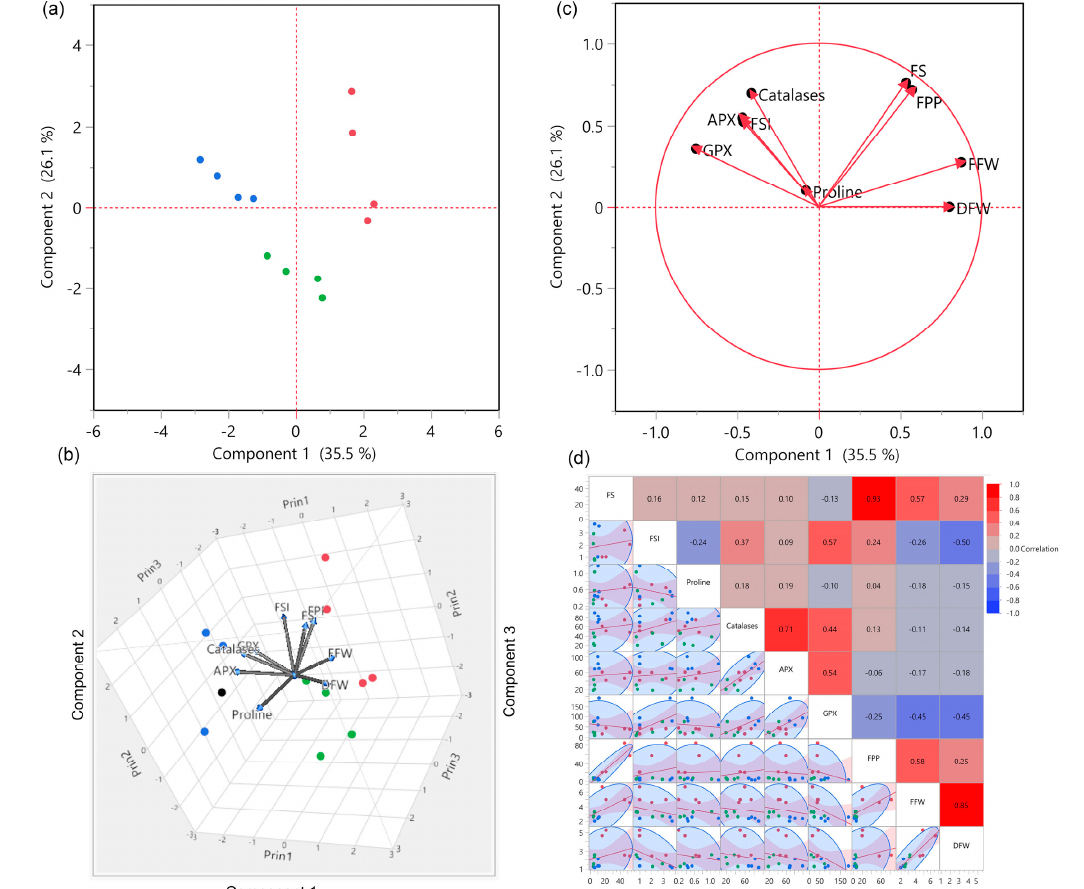
Figure 2. PCA, biplot, and correlogram of antioxidants and production traits in four hot and bell pepper genotypes under three different environments. ( a – c ) biplot distribution of four pepper genotypes under three different conditions. ( d ) correlogram of antioxidants and production traits. According to the color scheme, red indicates the cluster of genotypes under control, green under D(F), and blue under D(P).